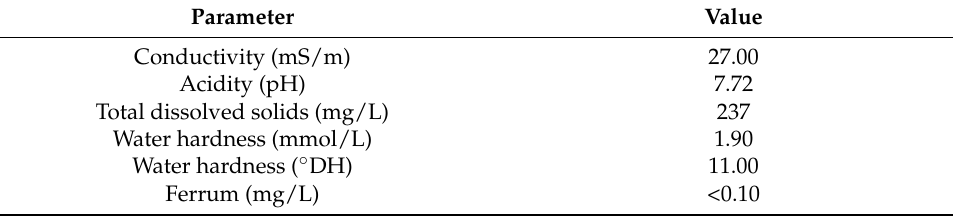
Table 3. Chemical properties of water.